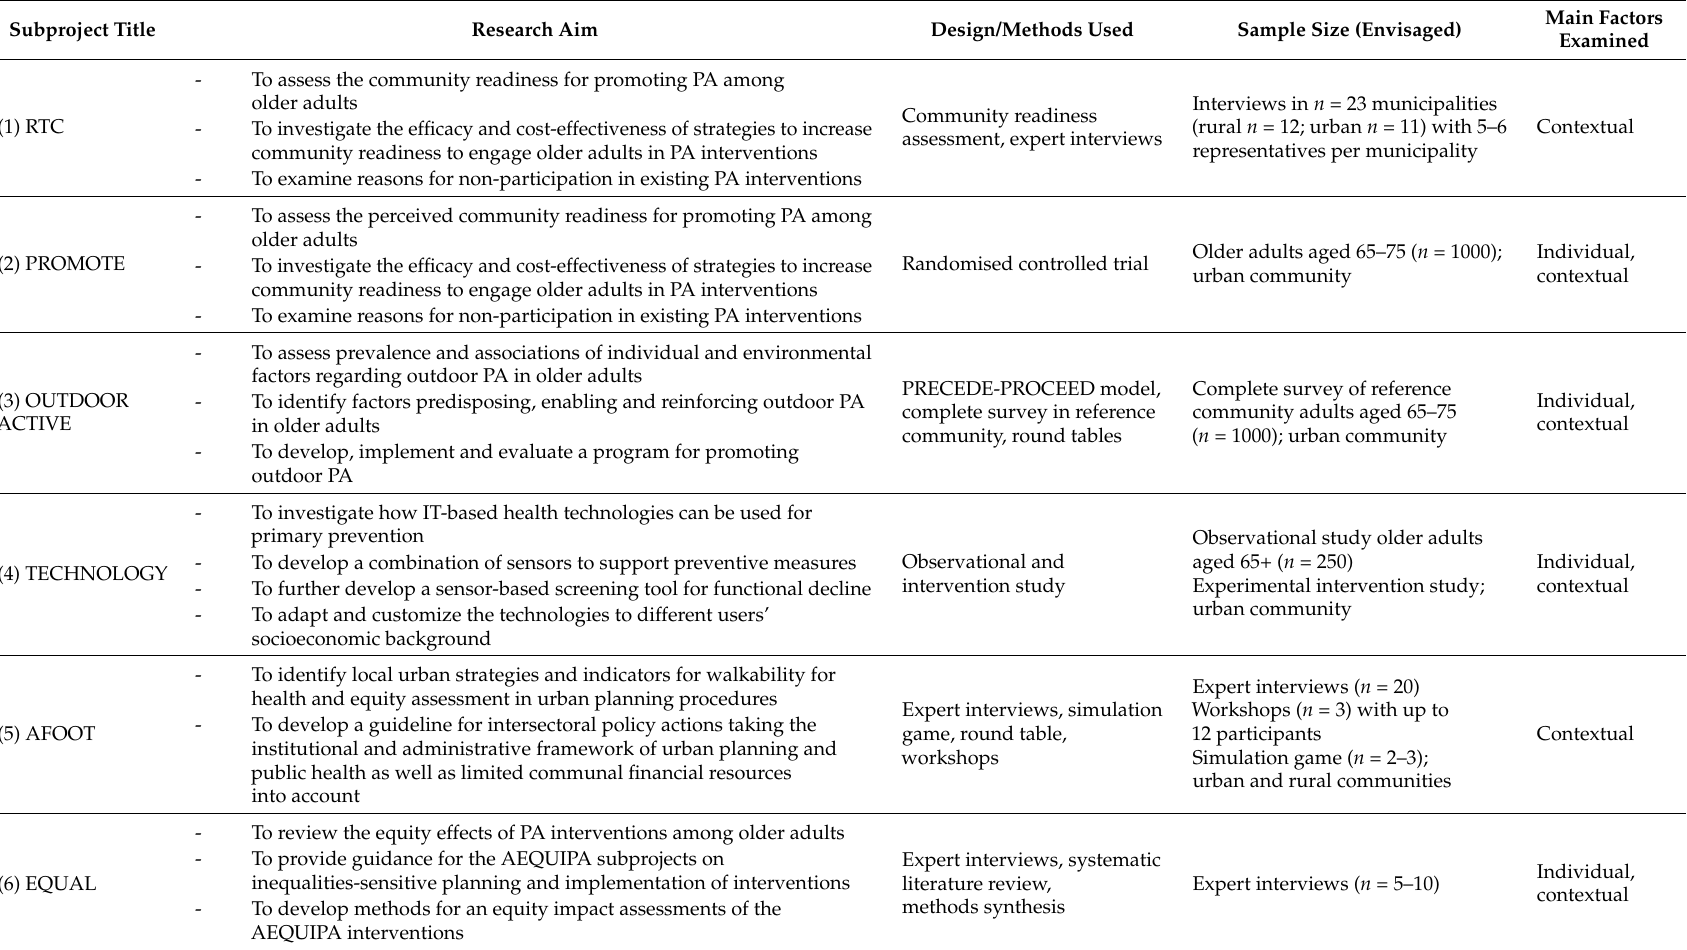
Table 1. Physical Activity and Health Equity (AEQUIPA) subprojects, research aim, design/methods used, envisaged sample size and main factors examined. Subproject